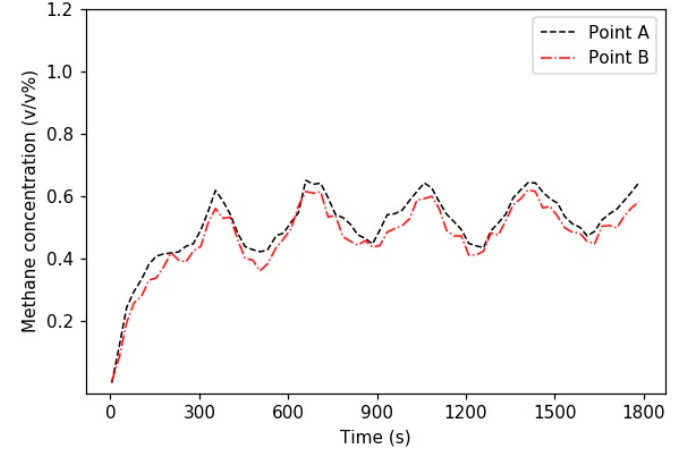
Figure 11. Methane concentration changed over time at two specified points. Table 4. Energy saving for case 7 in 1800 s.